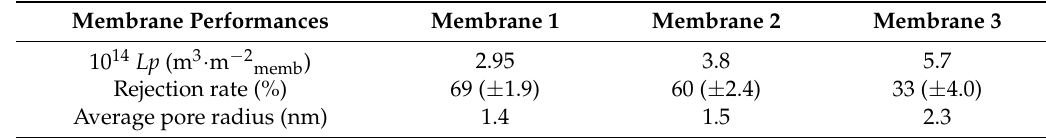
Table 1. Hydraulic permeabilities, rejection rate of Vitamin B12, and estimated mean pore radius of the different TiO 2